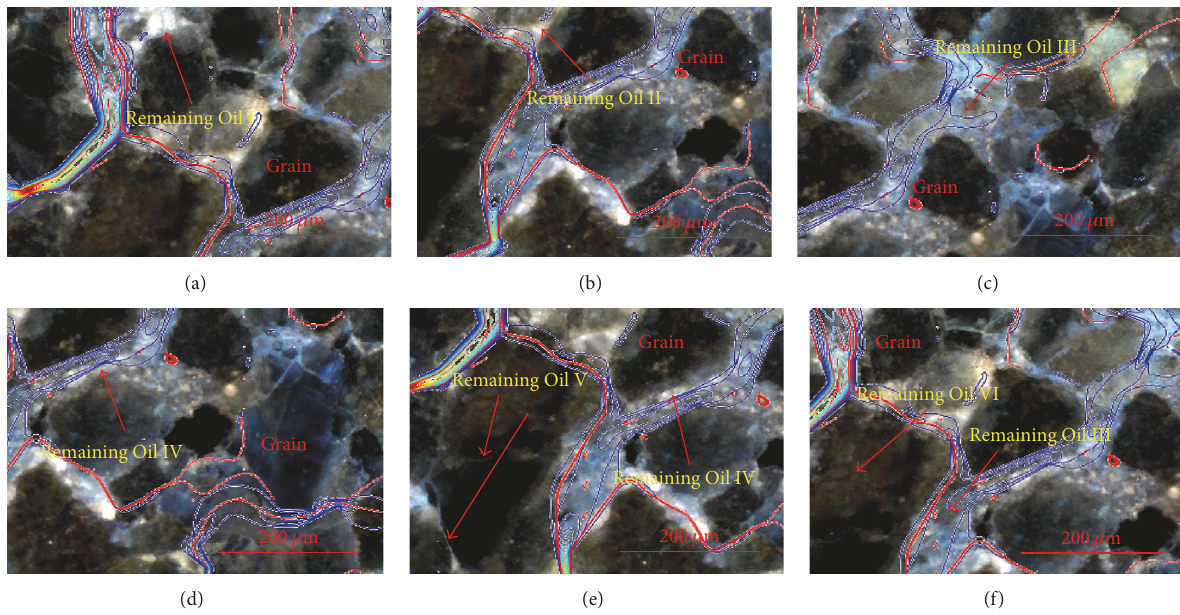
Figure 7: Types of microscopic remaining oil: the red line represented the high flow velocities and the blue line represented the low flow velocities. (a) Remaining Oil I: remaining oil of cluster state, (b) Remaining Oil II: remaining oil of cant state, (c) Remaining Oil III: remaining oil of intergranular adsorbing state, (d) Remaining Oil IV: remaining oil of state of thin film on pore surface, (e) Remaining Oil V: remaining oil of slit state, (f) Remaining Oil VI: remaining oil of particle adsorbing